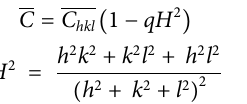
Figure 3A . In all of the DS-T heat treatment